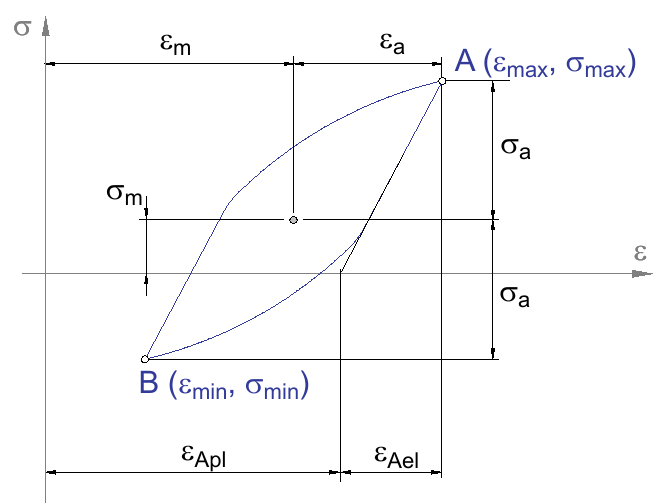
Figure 2: Description of the stable hysteresis loop